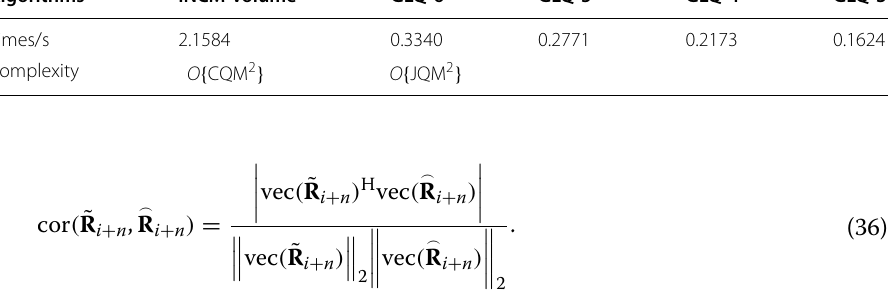
Table 1 Comparison of running times for different GLQ orders